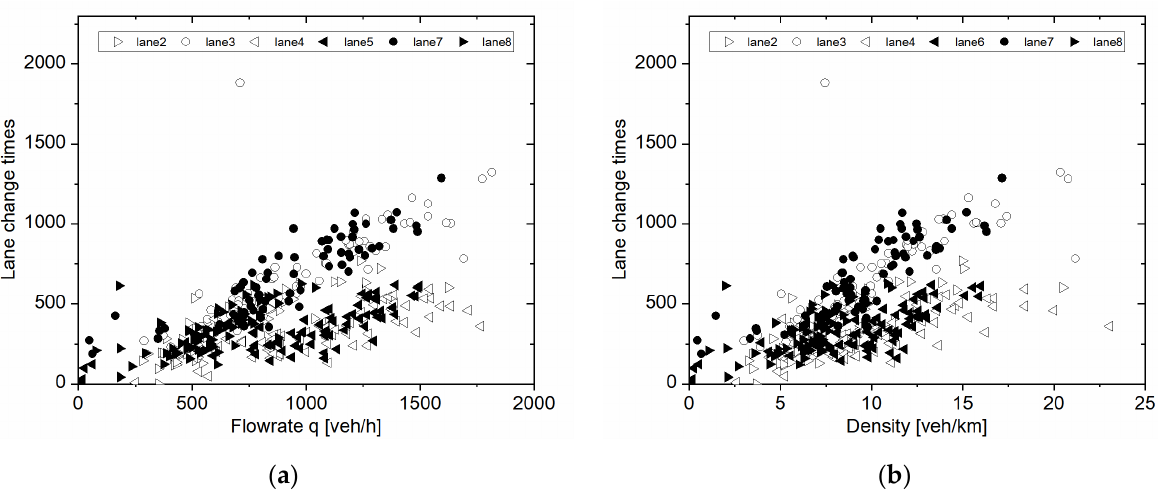
Figure 3. ( a ) Total lane change times versus flow rate; ( b ) Total lane change times versus density.